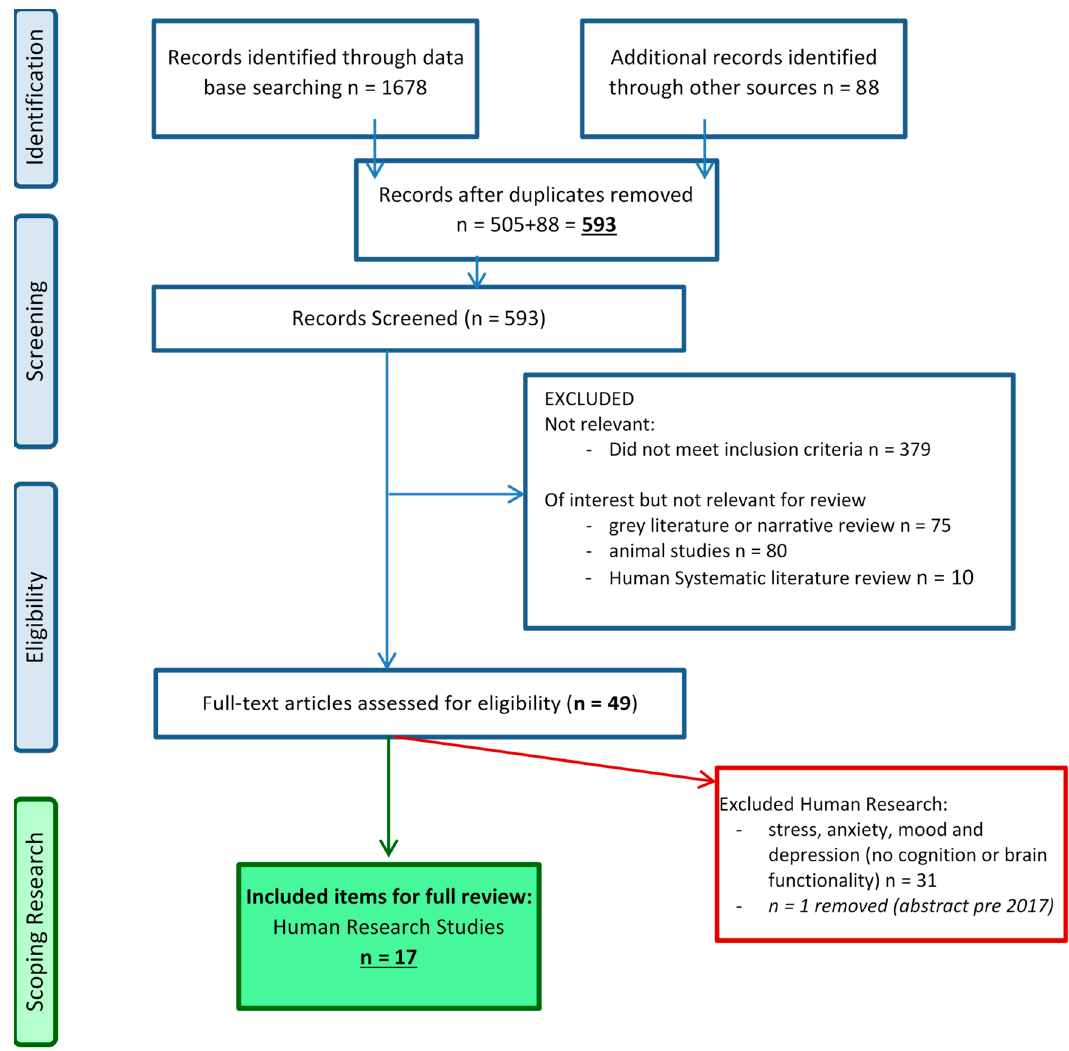
Figure 1. PRISMA 2009 search strategy Flow Diagram. Adapted from Moher et al.; The PRISMA Group (2009). Preferred Reporting Items for Systematic Reviews and Meta-Analyses: The PRISMA Statement. PLoS Med 6(7): e1000097. doi:10.1371/journal.pmed1000097. For more information, visit